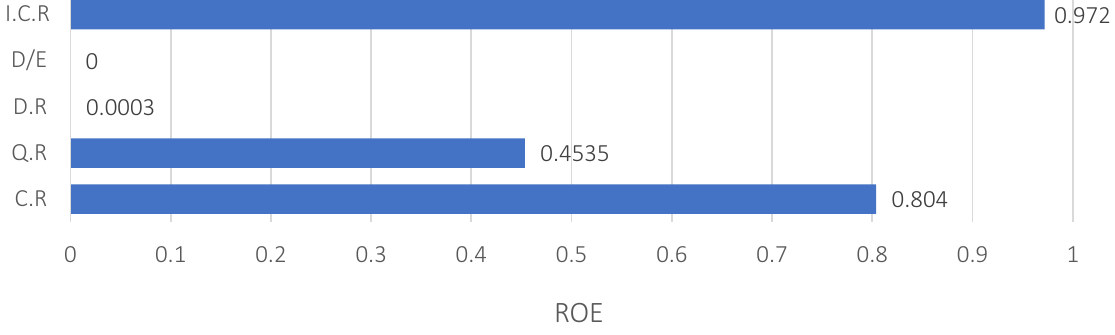
Figure 3. The relative impact of solvency, leverage, and liquidity on ROE